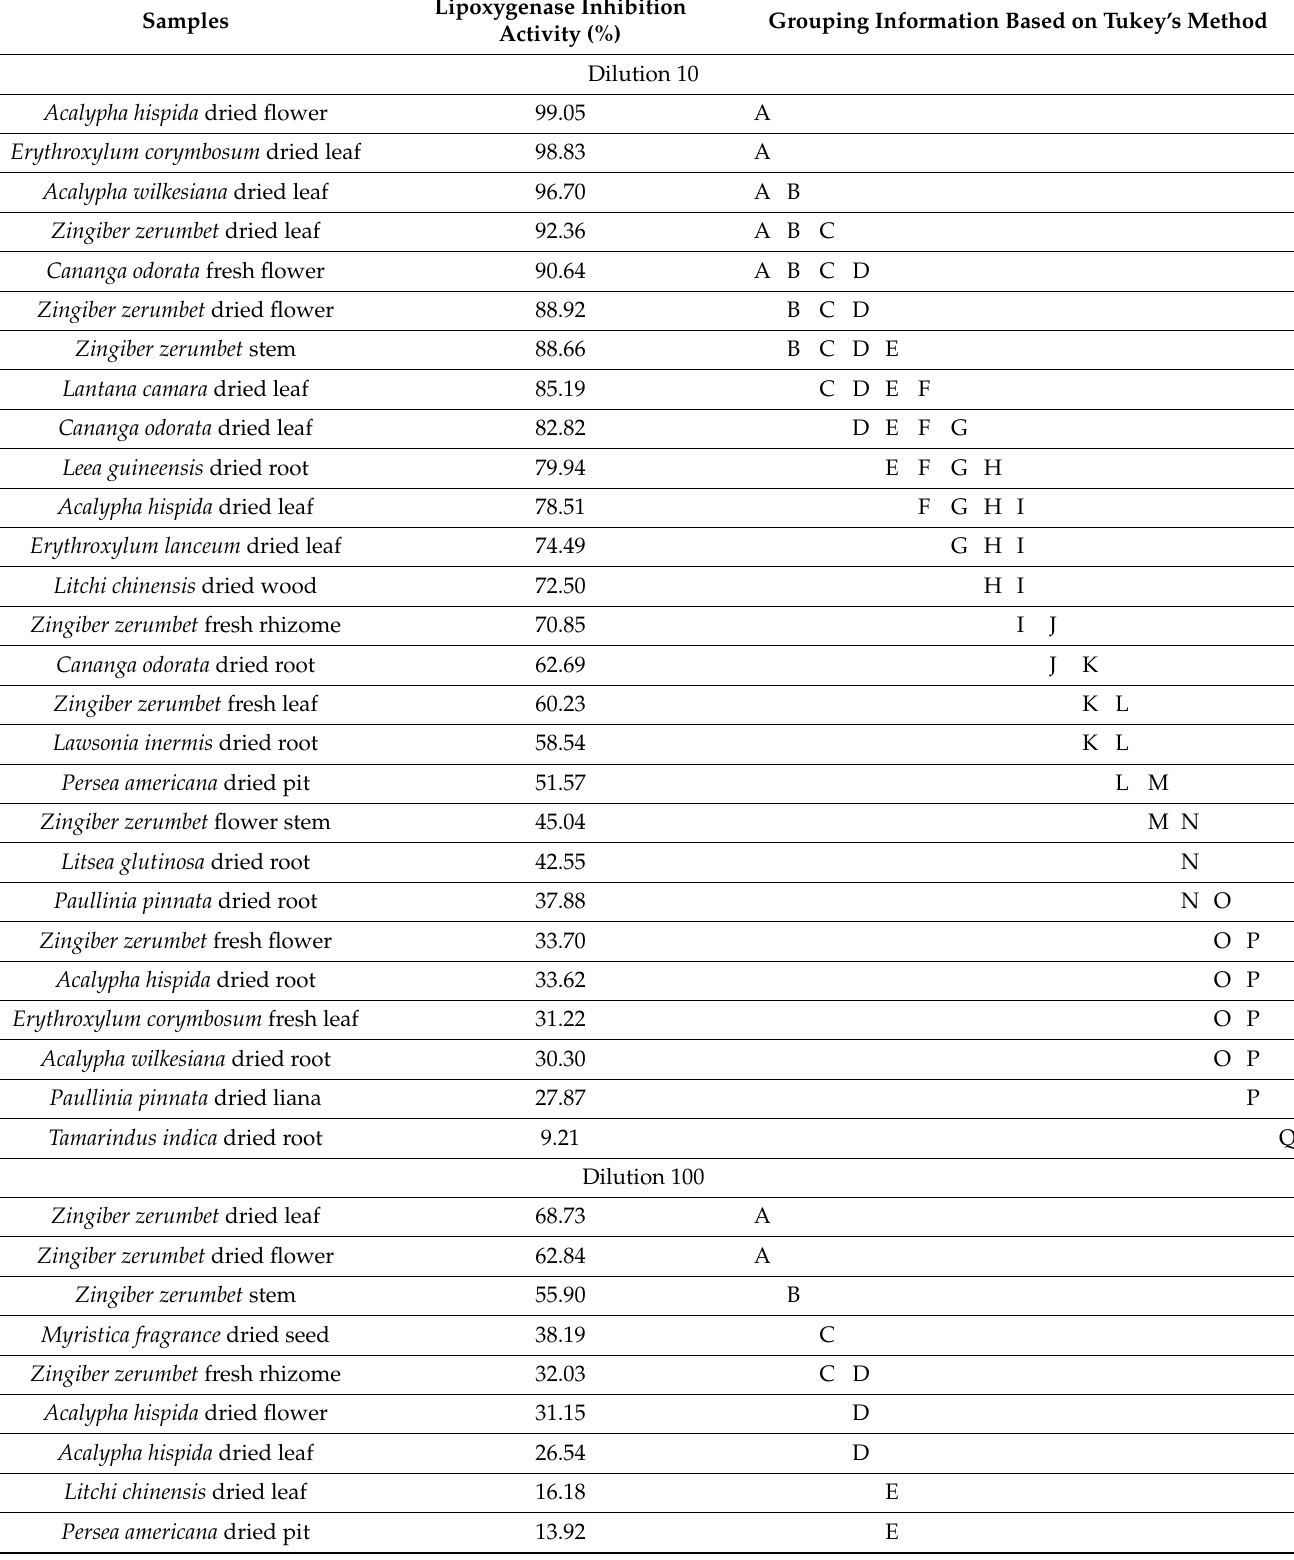
Table 2. Lipoxygenase inhibition activity results for the plant extracts diluted 10, 100 and 1000 times ( n = 3). Results were statistically analyzed using Tukey’s grouping test (confidence level: 95%), and the observed group classifications (A, B, C . . . . . . etc.) are shown in the present